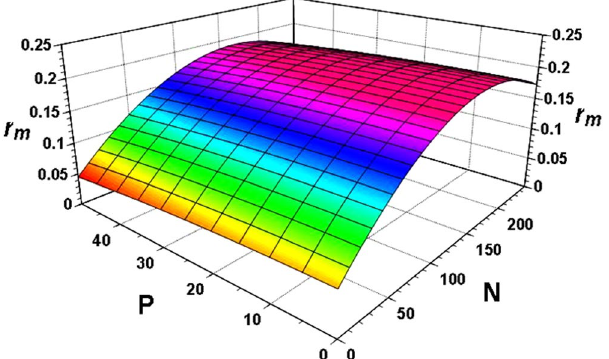
Figure 2. Effect of N and P on the increasing rate of natural increase ( r m ) of brown planthopper (BPH).